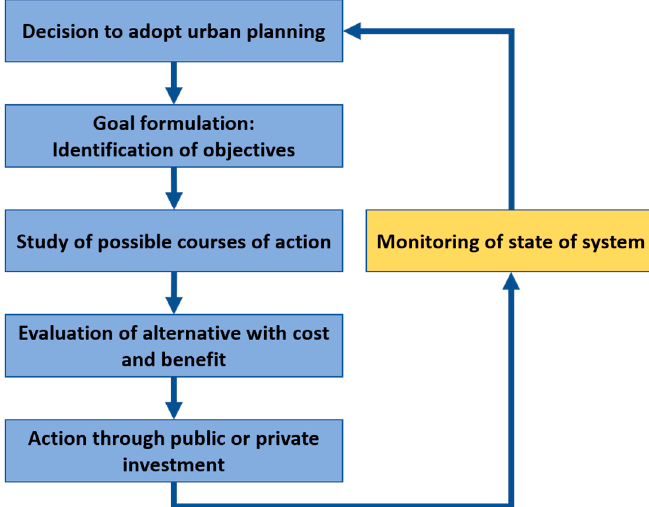
Figure 1. The McLoughlin implementation process. The planning process model interacts with the real world through comparative analyses and control processes